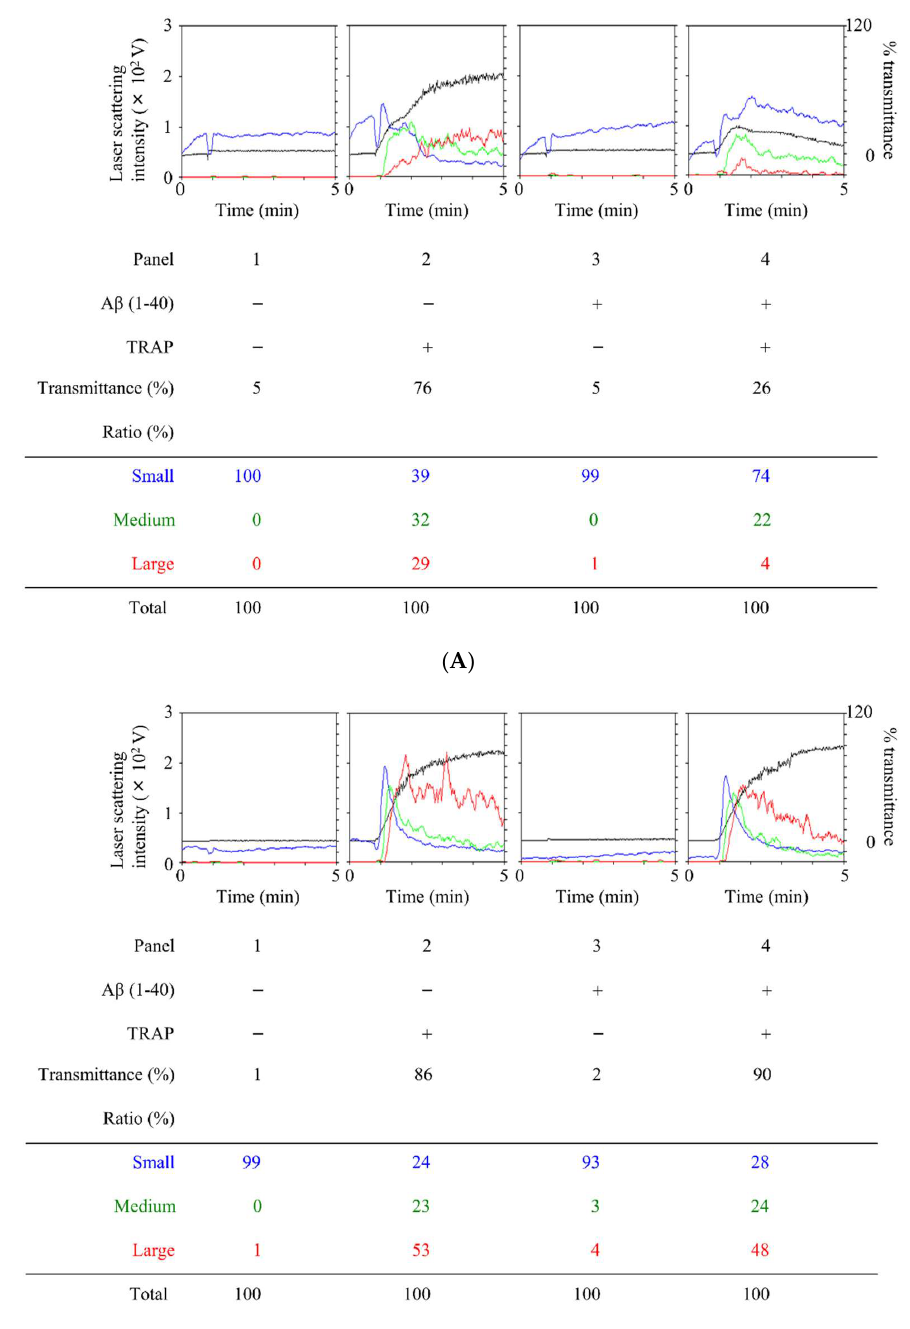
Figure 1. Effect of amyloid β protein (A β ) (1–40) on thrombin receptor-activating protein (TRAP)- stimulated aggregation of human platelets in diabetes mellitus (DM) patients. PRP from DM patients was pretreated with 10 µ M of A β (1–40) or vehicle at 37 ◦ C for 15 min and then stimulated with 8–15 µ M of TRAP or vehicle for 5 min. The dose of TRAP achieving a transmittance of 70–100% recorded using a PA-200 aggregometer (PA-200 apparatus; Kowa Co., Ltd., Tokyo, Japan) was adjusted individually. The black line indicates the percentage of transmittance of each sample (isolated platelets recorded as 0%, and PPP recorded as 100%). The blue line indicates small aggregates (9–25 µ m), the green line indicates medium aggregates (25–50 µ m), and the red line indicates large aggregates (50–70 µ m). The lower panel presents the distribution (%) of aggregated particle size, measured by laser scattering. The representative results of two different responsiveness to A β , suppressed ( A ) and unchanged ( B ), are presented,